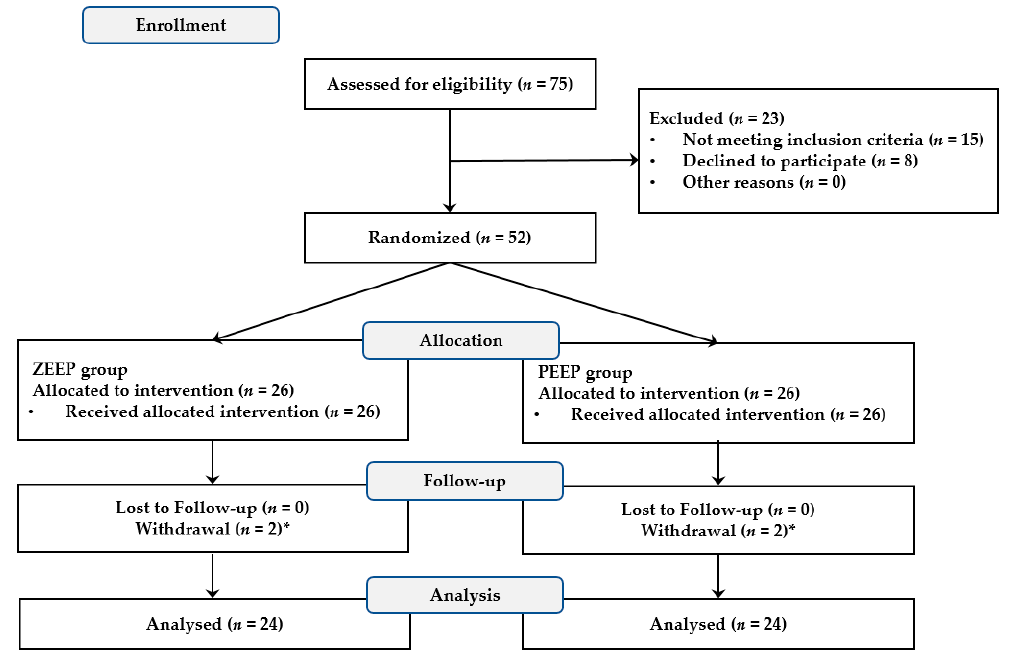
Figure 1. CONSORT flow diagram to illustrate the study design. * Two patients in the ZEEP group whose operation was altered to a thoracotomy and two patients in the PEEP group who had been transfused were withdrawn from the